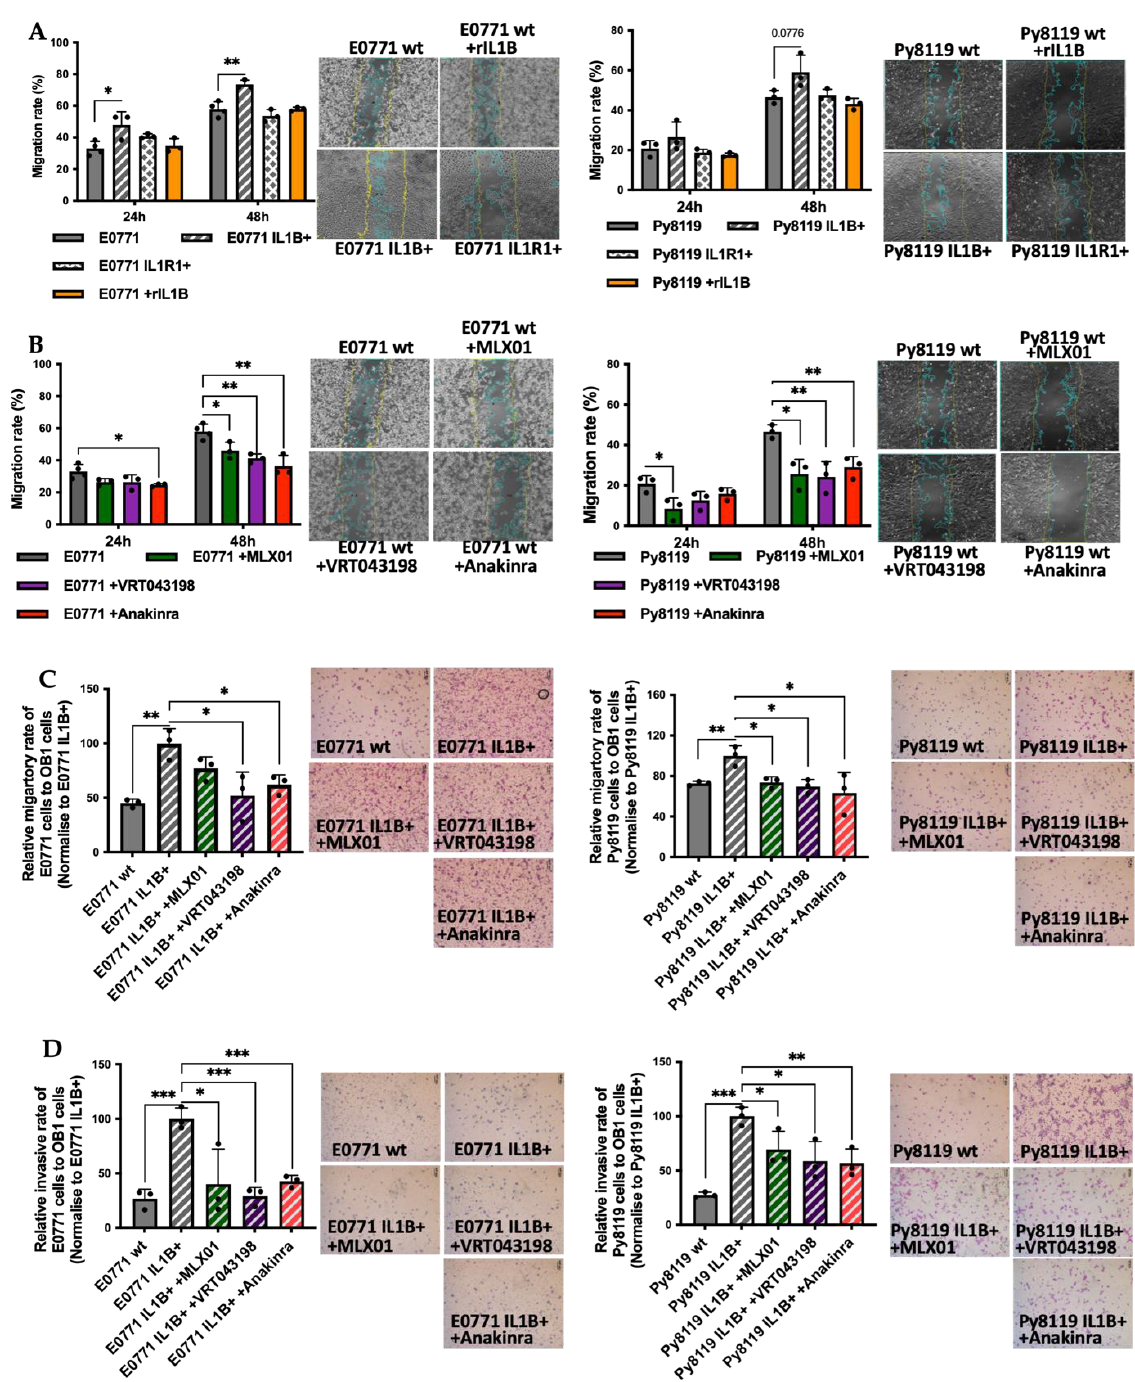
Figure 2. The effects of IL1β overexpression and inhibitors of the IL1β pathway on migration and invasion of E0771 and Py8119 breast cancer cells in vitro. ( A , B ) Effects of overexpression of IL1β (IL1B+), overexpression of IL1R1 (IL1R1+), inhibition of IL1β (12ng /mL MLX01), inhibition of Caspase-1 (25 ng/mL VRT043198), inhibition of IL1R (0.1 mg/kg Anakinra) on cell migration of wide type E0771 and Py8119 cells. Data are presented as the percent of scratch closure following 24 h and 48 h in culture, normalised for the beginning of scratch. Representative images of cells at 48 h are shown where the yellow and blue lines are scratch edges at 0 h and 48 h, respectively. ( C , D ) The effects of alteration of IL1β signalling on migration and invasion towards pre -osteoblast for 24 h (OB1 cells). All experiments are from three biological experiments and their graphs represent mean + SD, * p < 0.05, ** p < 0.01, *** p < 0.001.